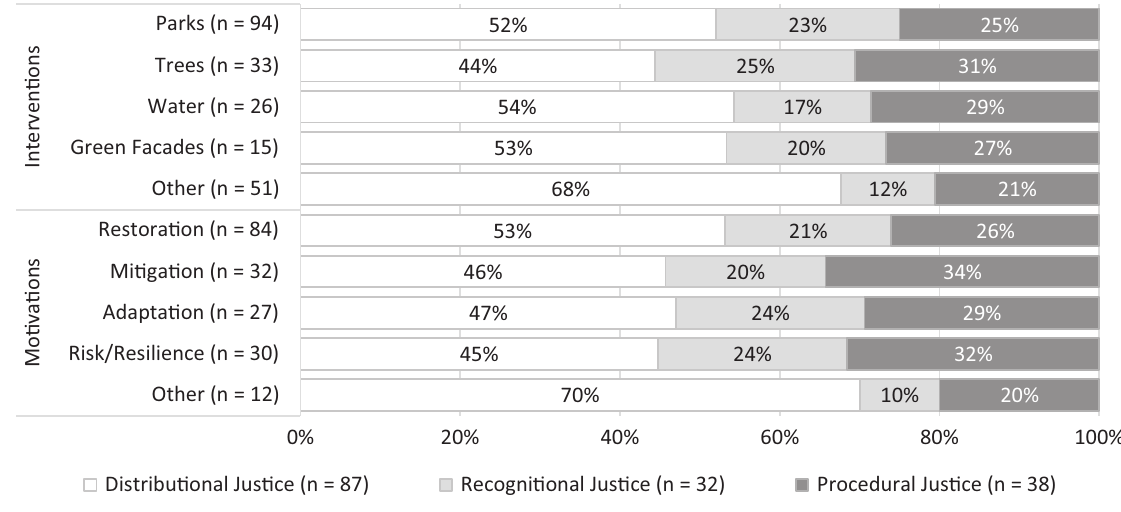
Figure 4. Types, motivations, and dimensions of